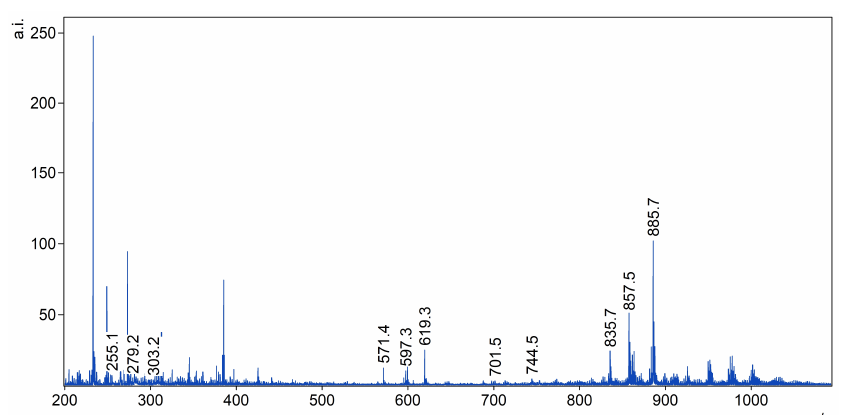
Figure 1. Peaks chosen for the analysis in the negative ionization mode (marked by their m / z ratios).